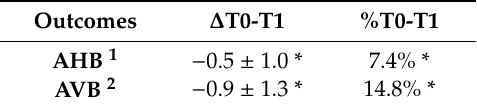
Table 3. Dimensional tissue changes at T0 (ridge preservation procedure) and T1 (six months follow-up). Mean value and standard deviation were expressed in millimeter. Percentage (%) of bone loss between initial and re-entry values was